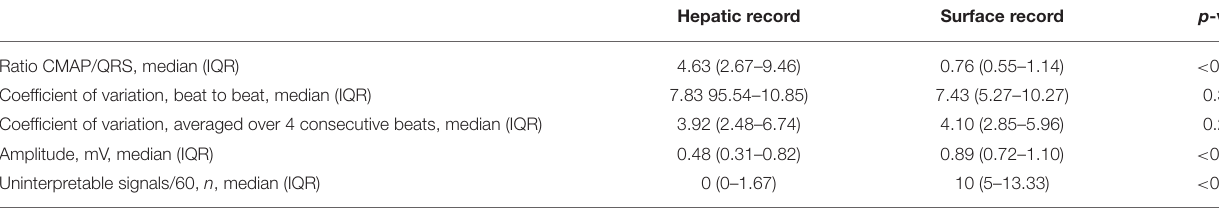
TABLE 2 | Primary and secondary outcomes of stage 1: basal CMAP recording during 60s before any right-sided cryoapplication.